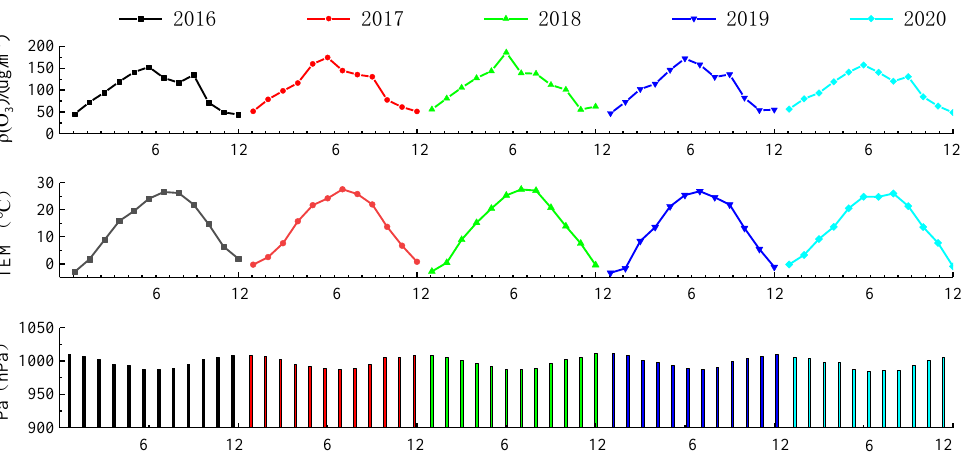
Figure 8. Variation in O 3 concentrations and meteorological conditions in the NCP from 2016 to 2020.